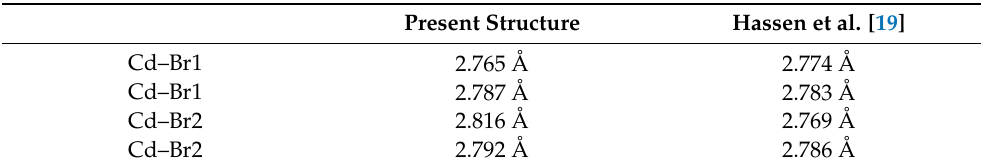
Table 2. Atomic distances for CH 3 NH 3 CdBr 3 from the Rietveld refinements in comparison with those reported by Hassen et